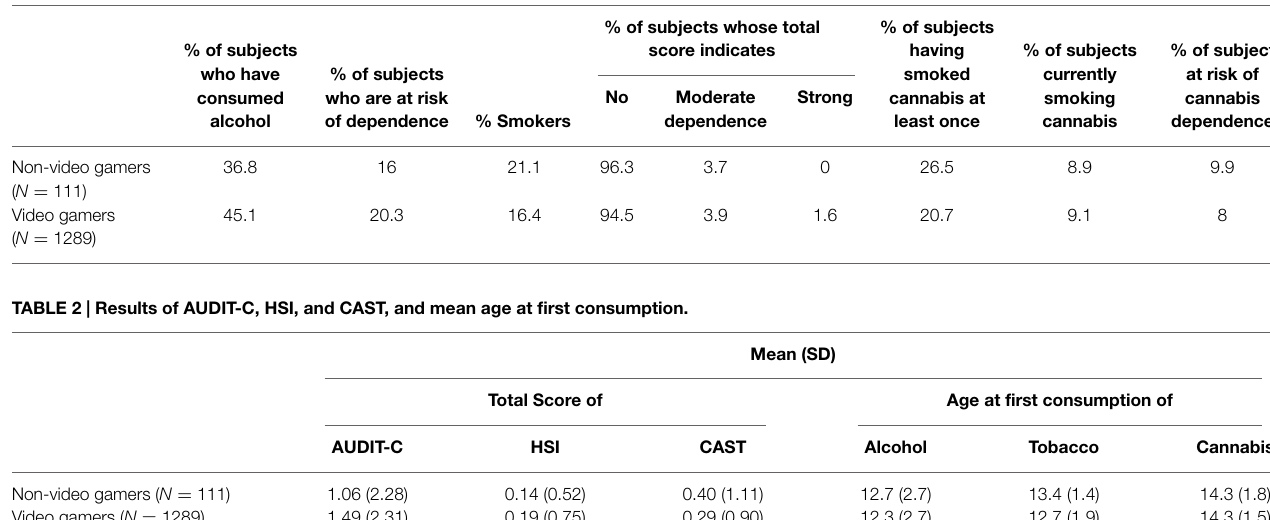
TABLE 1 | Percentage (%) of consumers and subjects at risk of dependence.